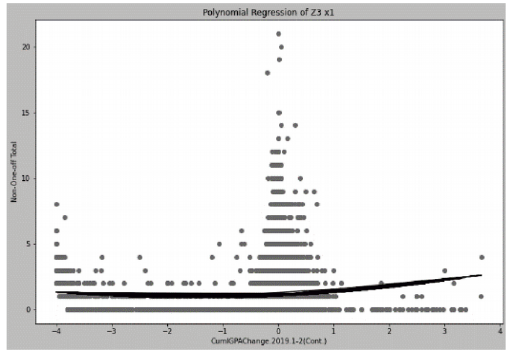
Figure 11. Polynomial Regression of Z3 x1 in Finding 1